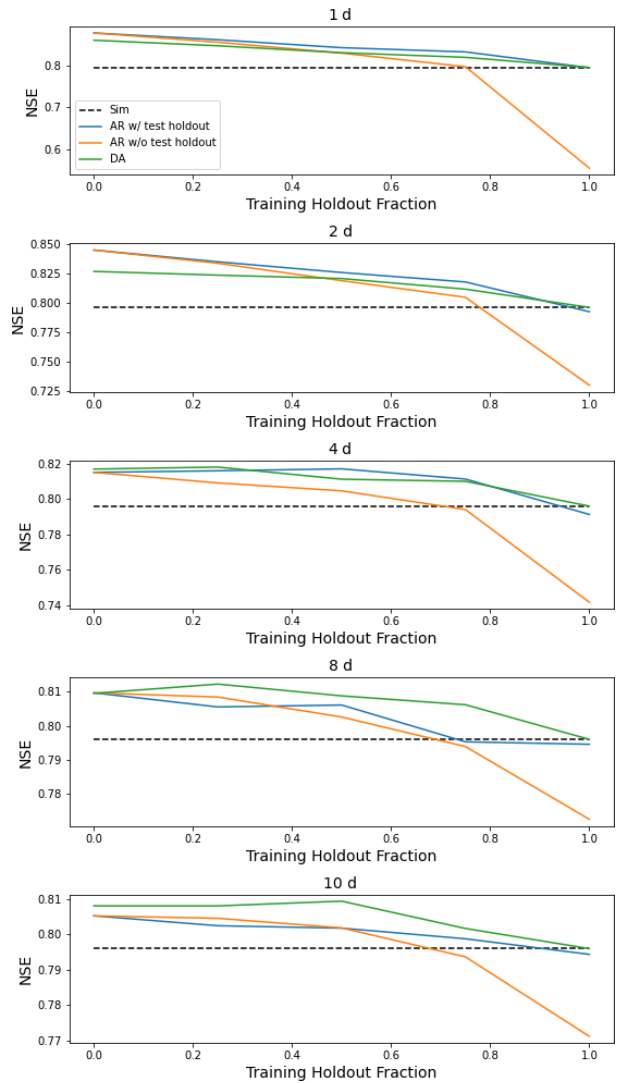
Figure 4. Median NSE over 531 basins of four models (simulation, AR trained with and without holdout data, and DA) as a function of lag time in days and fraction of missing lagged streamflow data in the test period. The AR and DA models here used 0% missing data during inference. Notice the different scales on the y